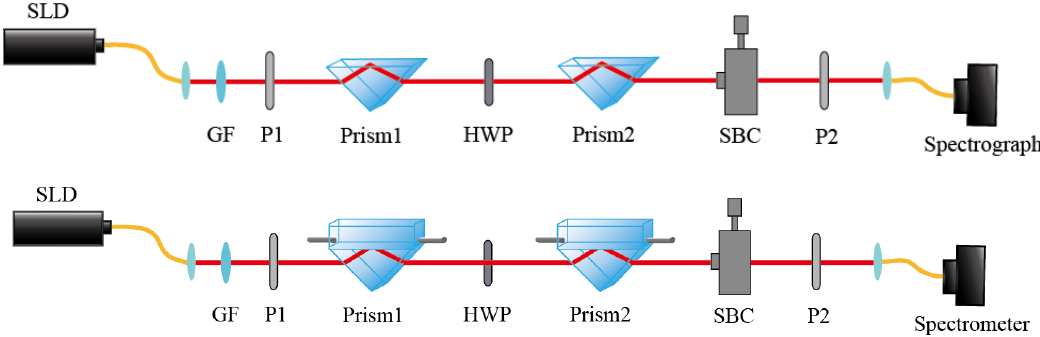
Figure 1. System structure diagram. SLD: superluminescent laser diode; GF: Gaussian filter; HWP: half-wave plate; SBC: Soleil–Babinet compensator.